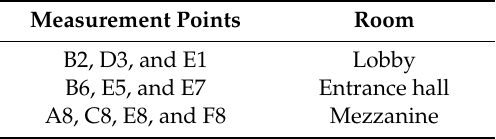
Table 3. Measurement points of indoor noise.